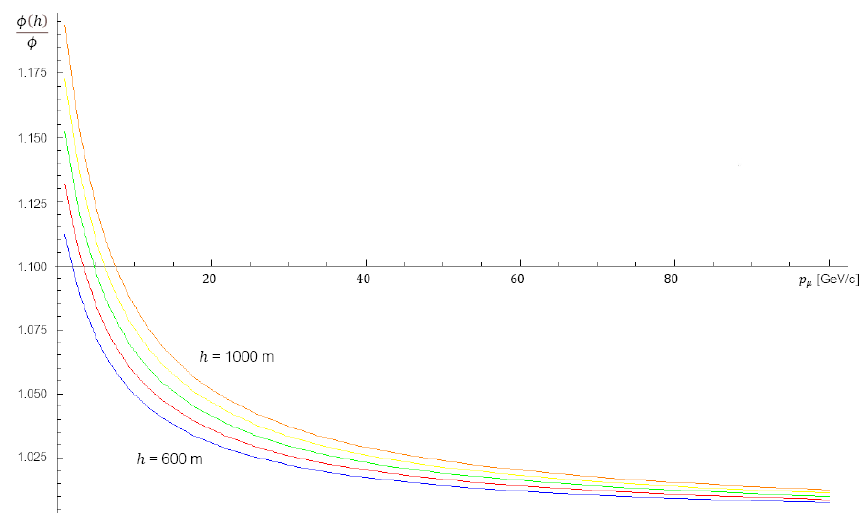
Figure 3. Trends in the ratio between the flux at different altitudes h and the flux at sea level as a function of the muons energy. The comparison of the curves gives the expected percentage change in the flux of muons at different